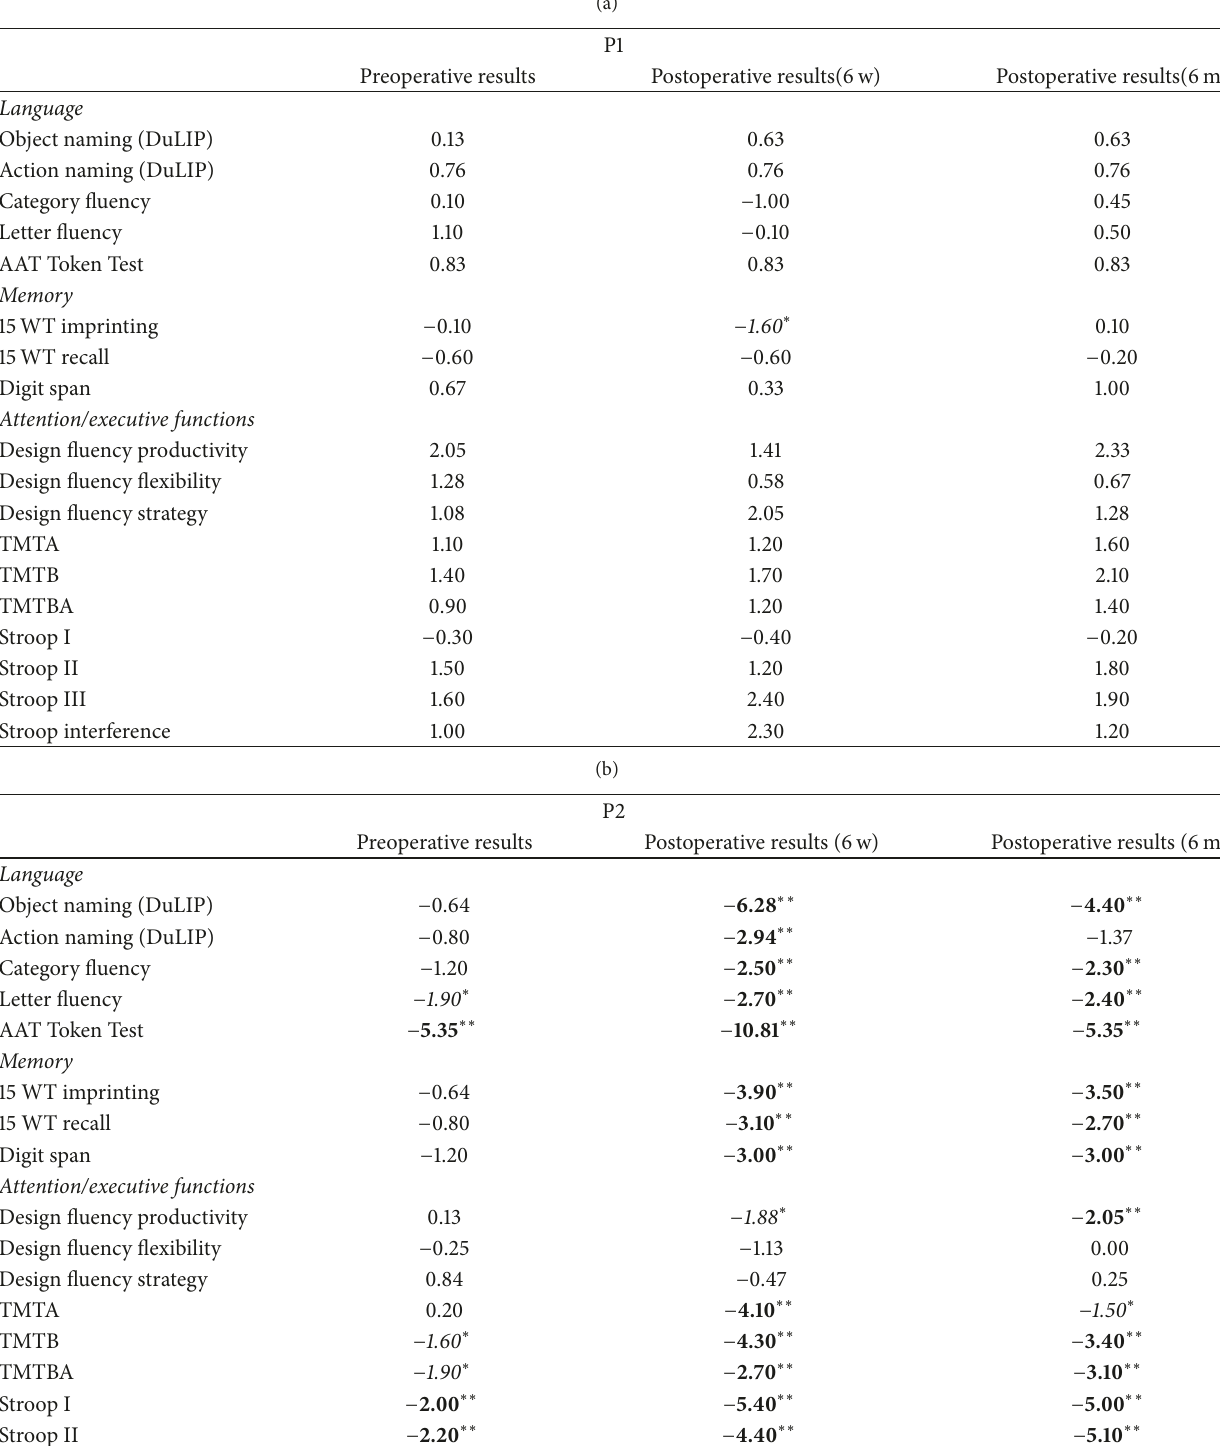
Table 3: Pre- and postoperative neuropsychological test-scores P1–P4 (a–d). w = weeks, m = months, and y = years. ∗∗ Pathological